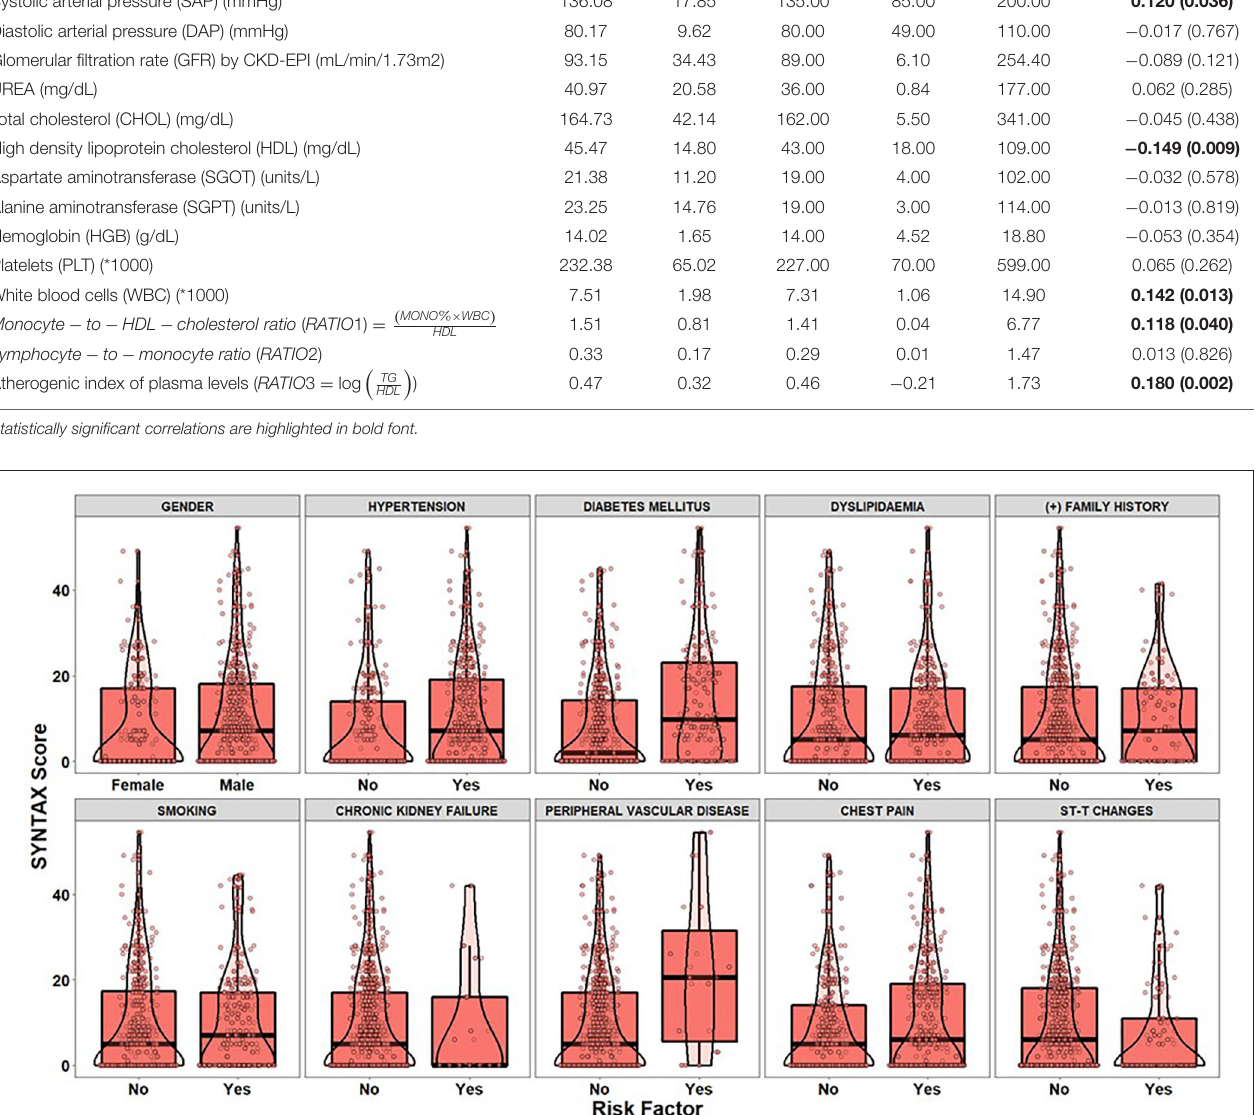
visualizes the results derived from the execution of the Boruta algorithm on the building phase of the zero-part model. In particular, the boxplots visualize the distributions of the z - scores produced by the Boruta algorithm for the examined risk factors, where risk factors confirmed as “ informative ” are highlighted with green colour. In contrast, risk factors that were characterized as “ non-informative ” are depicted with purple colour. Furthermore, risk factors yielding important scores